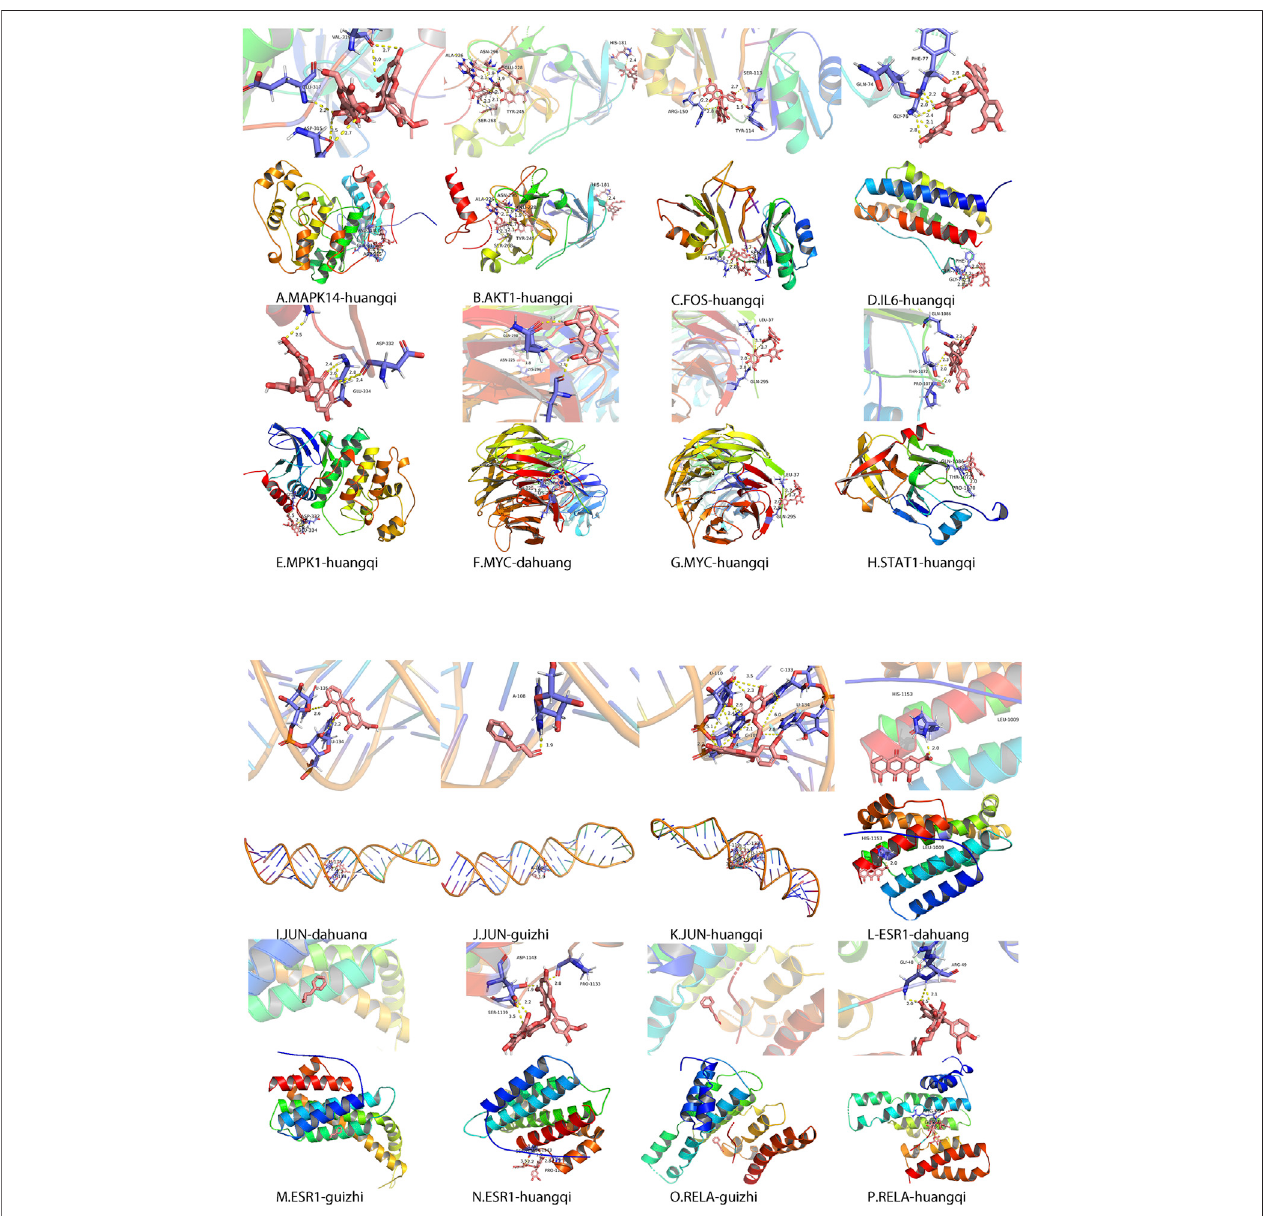
FIGURE 5 | Molecular docking of related protein molecules of ZLH. (A) MAPK14 – Huangqi. (B) AKT1 – Huangqi. (C) FOS – Huangqi. (D) IL-6 – Huangqi. (E) MAPK1 – Huangqi. (F) MYC – Dahuang. (G) MYC – Huangqi. (H) STAT1 – Huangqi. (I) JUN – Dahuang. (J) JUN – Guizhi. (K) Jun – Huangqi. (L) ESR1 – Dahuang. (M) ESR1 – Guizhi. (N) ESR1 – Huangqi. (O) RELA – Guizhi. (P) RELA –